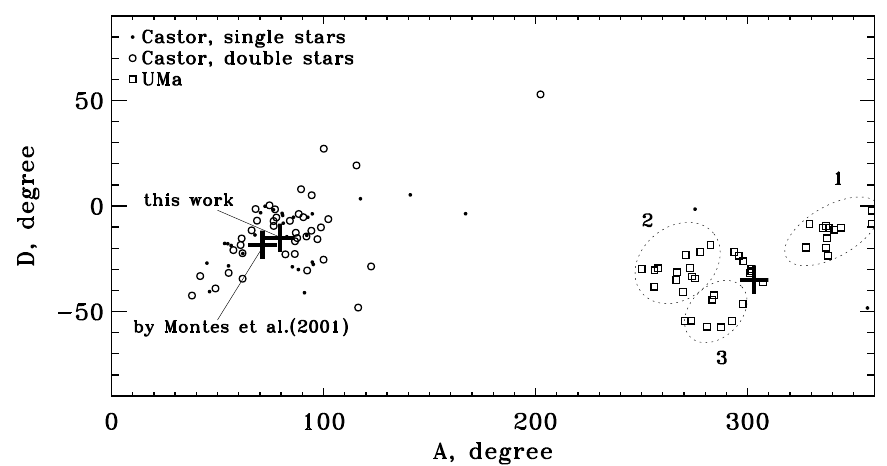
Fig. 2. The AD-diagram for the Castor (open circles) and UMa (open squares) streams. The big crosses indicate the stream apex positions.